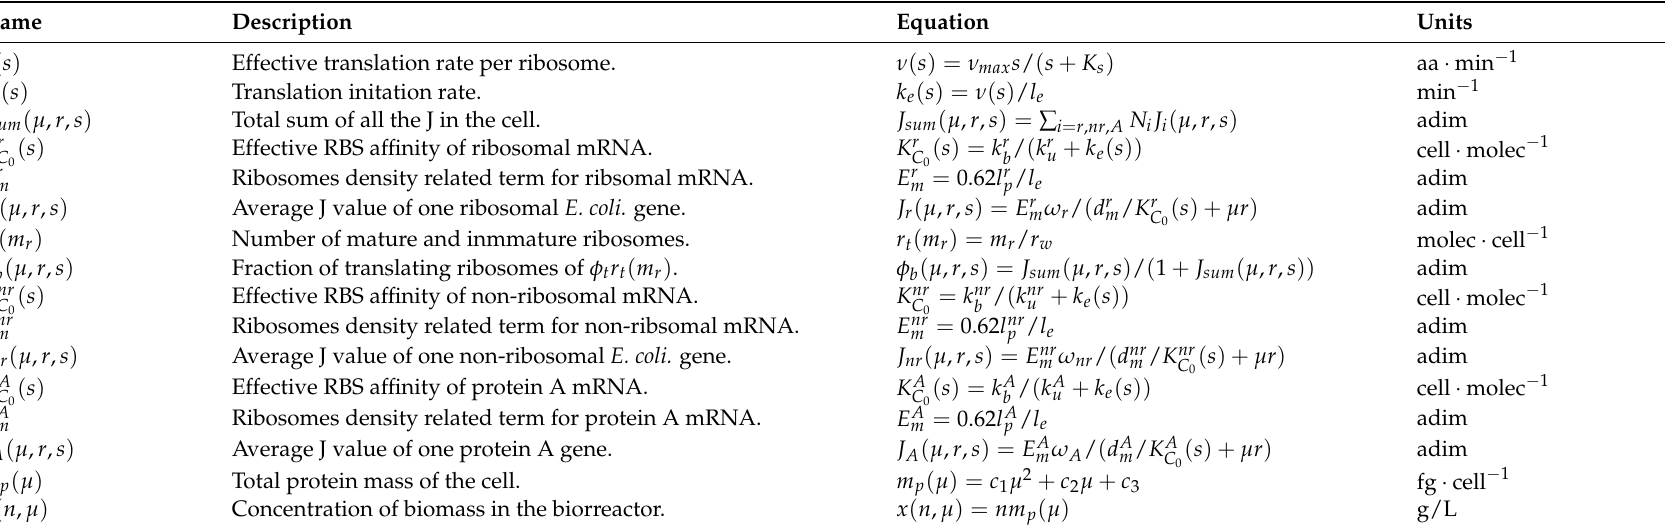
Table 2. Internal variables of the model.